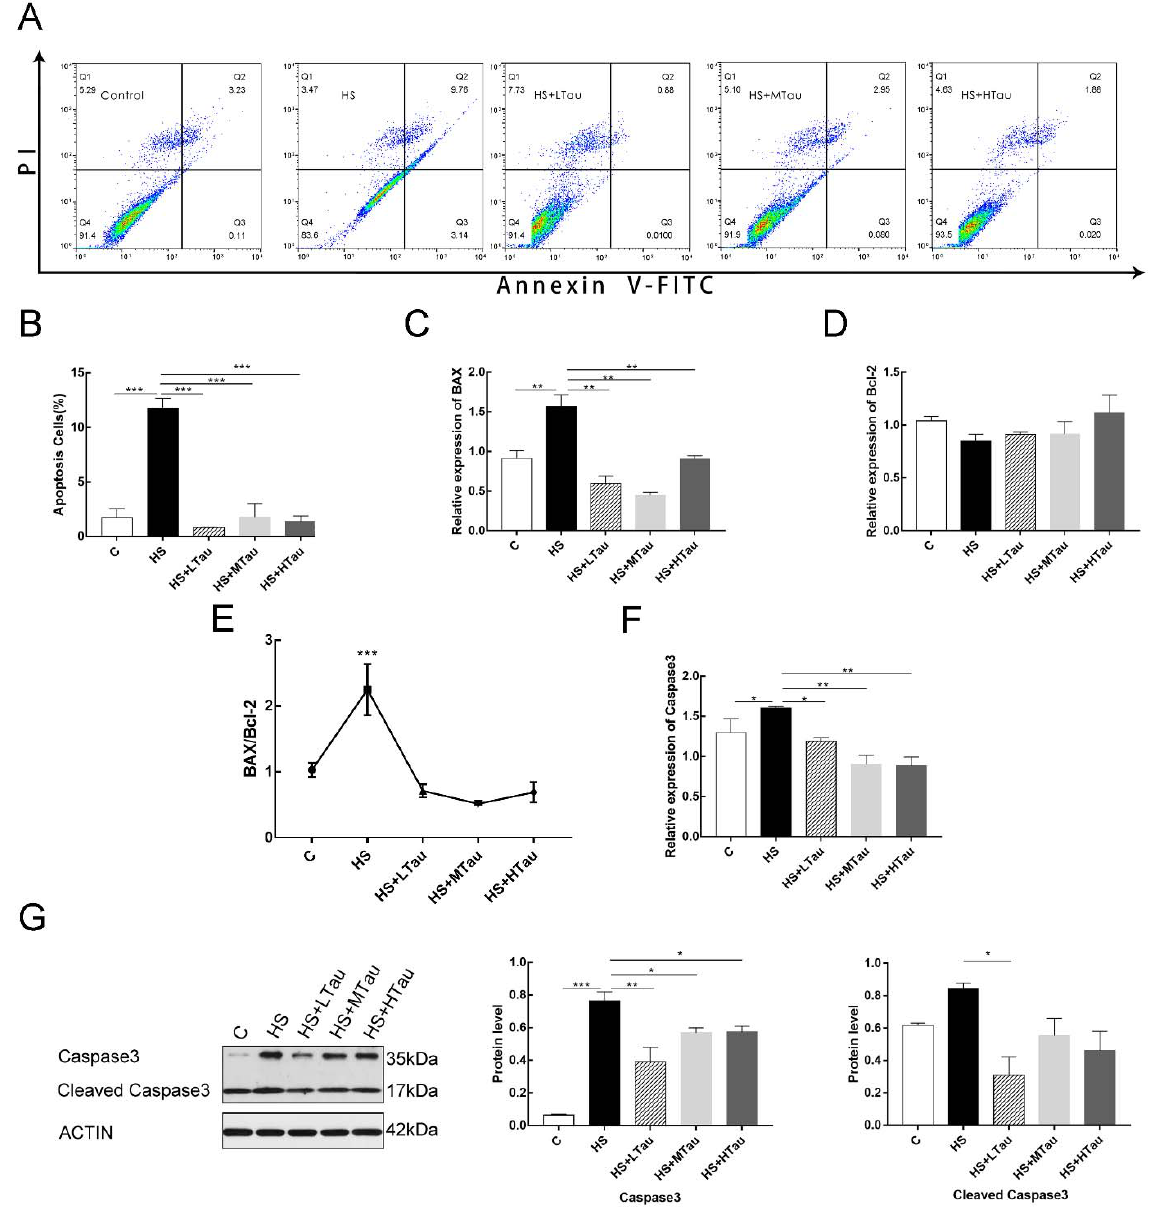
Figure 5. Taurine pretreatments attenuated cell apoptosis in MAC-T cells under heat exposure. ( A ) effects of taurine on apoptosis in MAC-T cells induced by heat shock analyzed via flow cytometry. ( B ) cell apoptosis rates. ( C ) mRNA abundance of BCL2 associated X, apoptosis regulator (BAX). ( D ) mRNA abundance of BCL2 apoptosis regulator (Bcl-2). ( E ) the ratio of BAX/Bcl-2. ( F ) mRNA abundance of caspase3. ( G ) the protein expression of caspase3 and cleaved caspase3 were determined by Western blotting. All data are presented as the mean ± SEM. * p < 0.05; ** p < 0.01; *** p < 0.001.